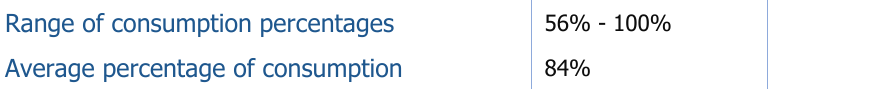
Table 5. Percentages for Youth’s Consumption of Sweetened Beverages